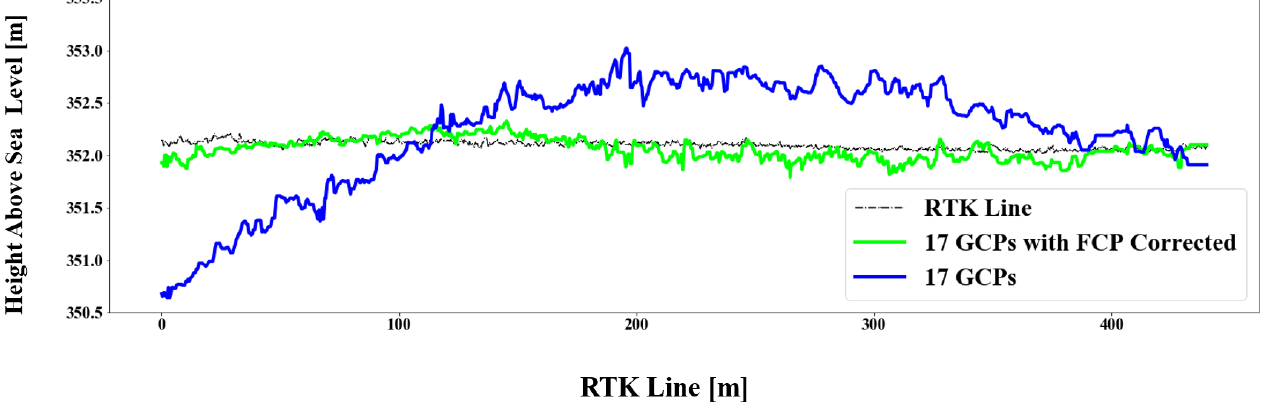
Figure 12. A visualisation of the effect of correcting the doming effect.